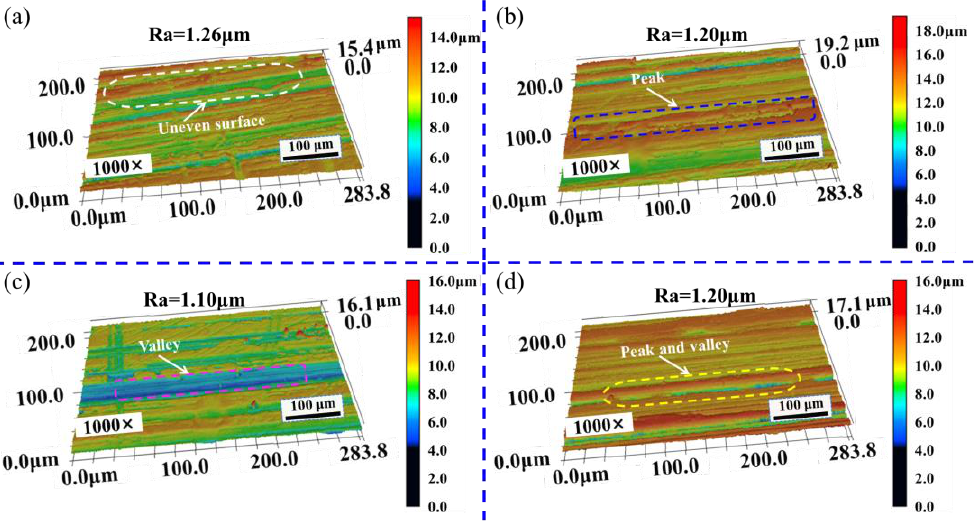
Figure 9. Three-dimensional morphologies of polished surface under different spot overlap ratios before cleaning. ( a ) 99.52%; ( b ) 98.55%; ( c ) 97.58%; ( d ) 96.62% (observed by LSCM at 1000 × magnifications).